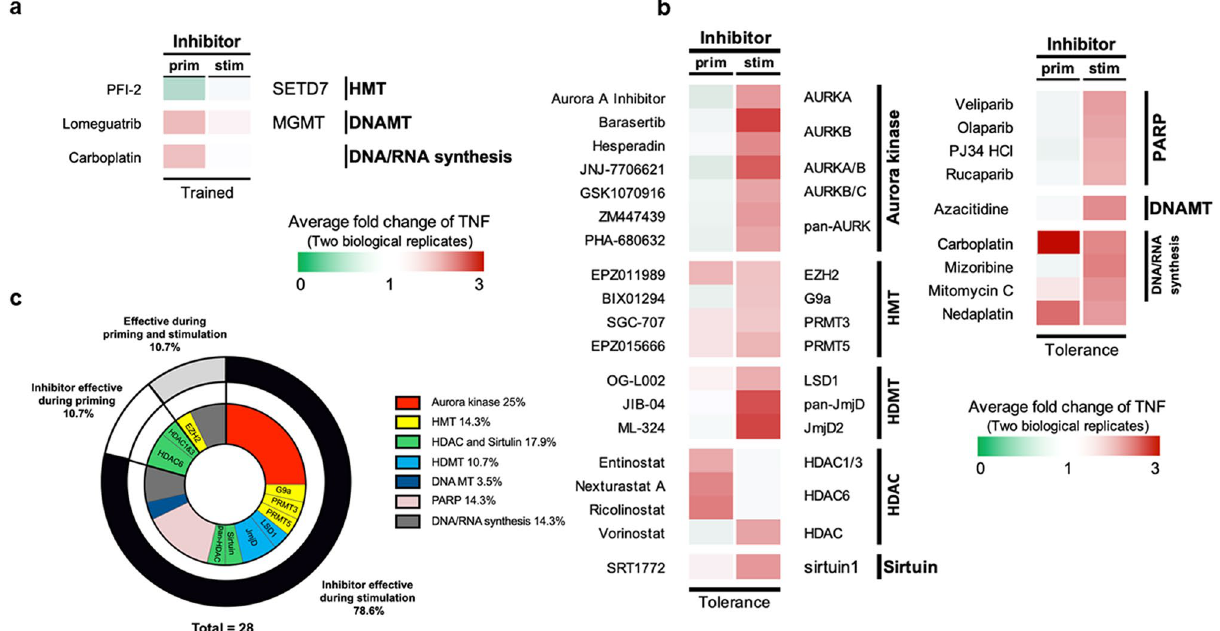
Figure 2. Compounds that showed enhanced or suppressed TNFα production in BG-trained and LPS- tolerant macrophages. ( a ) The relative fold changes of TNFα produced from compound-treated BG-trained macrophages (priming step or stimulation step) were calculated by normalizing to the amount of TNFα produced from vehicle control treatment of BG-trained macrophages. Average fold changes of two biological replicates are shown as heatmap format. Only compounds that increased the relative fold changes of TNFα more than 1.5-fold or lower than 0.75-fold are shown. ( b ) The relative fold changes of TNFα produced from compound-treated LPS-tolerant macrophages (priming step or stimulation step) were calculated by normalizing to the amount of TNFα produced from vehicle control treatment of LPS-tolerant macrophages. The fold changes are the average of two biological replicates and shown as heatmap format. Only compounds that increased the relative fold changes of TNFα more than 1.5-fold are shown. ( c ) Targets of suppressing inhibitors were classified based on function and time